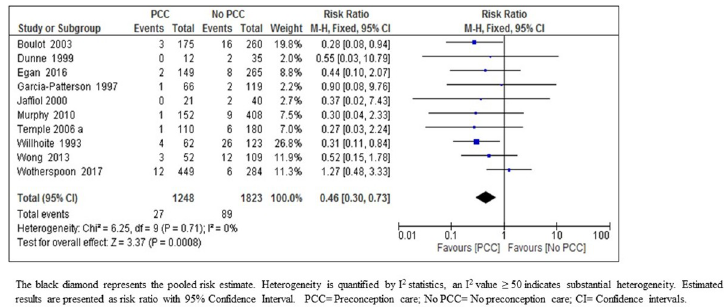
Fig 7. Risk ratio for perinatal mortality from ten studies of women with pre-existing diabetes mellitus who did or did not receive preconception care.